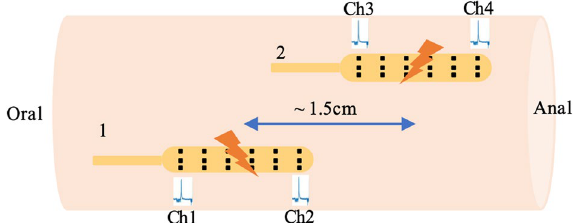
Figure 1. Experiment protocol. Direct distal colon stimulation: 5 cycles of alternating stimulation of electrodes #1 and #2 (total of 10 consecutive cycles) at 10 Hz, 2 ms, 15 mA, 30 s ON, 60 s OFF. Electrodes #1 and #2 were also used for recording, each containing four recording sites Ch1, Ch2, Ch3, and Ch4. The distance between the first two channels (Ch1–Ch2) and last two channels (Ch3–Ch4) is 1.5 cm, while Ch2 and Ch3 are separated by a distance of 3